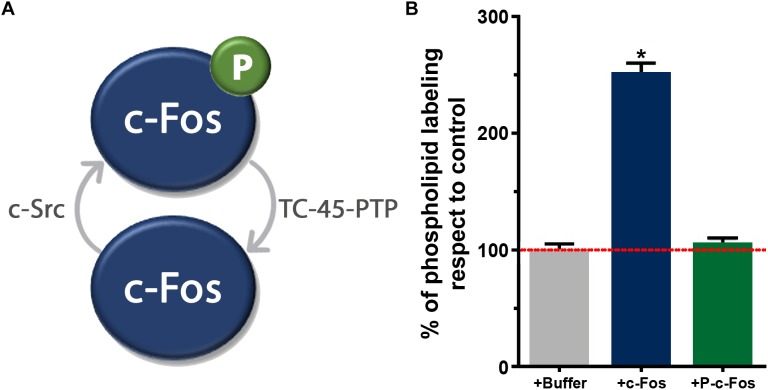
(A) Schematic representation of the phosphorylation/dephosphorylation cycle of the tyrosine residues of c-Fos by the kinase c-Src and the phosphatase TC-45-PTP. Dephosphorylated c-Fos is able to associate to ER membranes whereas phosphorylated c-Fos is not. (B) Labeling of total phospholipids in T98G cells homogenates in the presence of recombinant dephosphorylated c-Fos and phosphorylated c-Fos (obtained after incubation with recombinant c-Src). The capacity to incorporate [32P] to phospholipids from [32P]-ATP was measured in vitro. The results are the mean ± SD of two experiments performed in triplicate. ∗p < 0.002 with respect to the control, as determined by Student’s two-tailed t-test. Adapted from Ferrero et al., 2012 (ownership of copyright in original Springer Nature research articles remains with the Author, and provided that, when reproducing the contribution or extracts from it or from the Supplementary Information, the author acknowledges first and reference publication in the Journal).